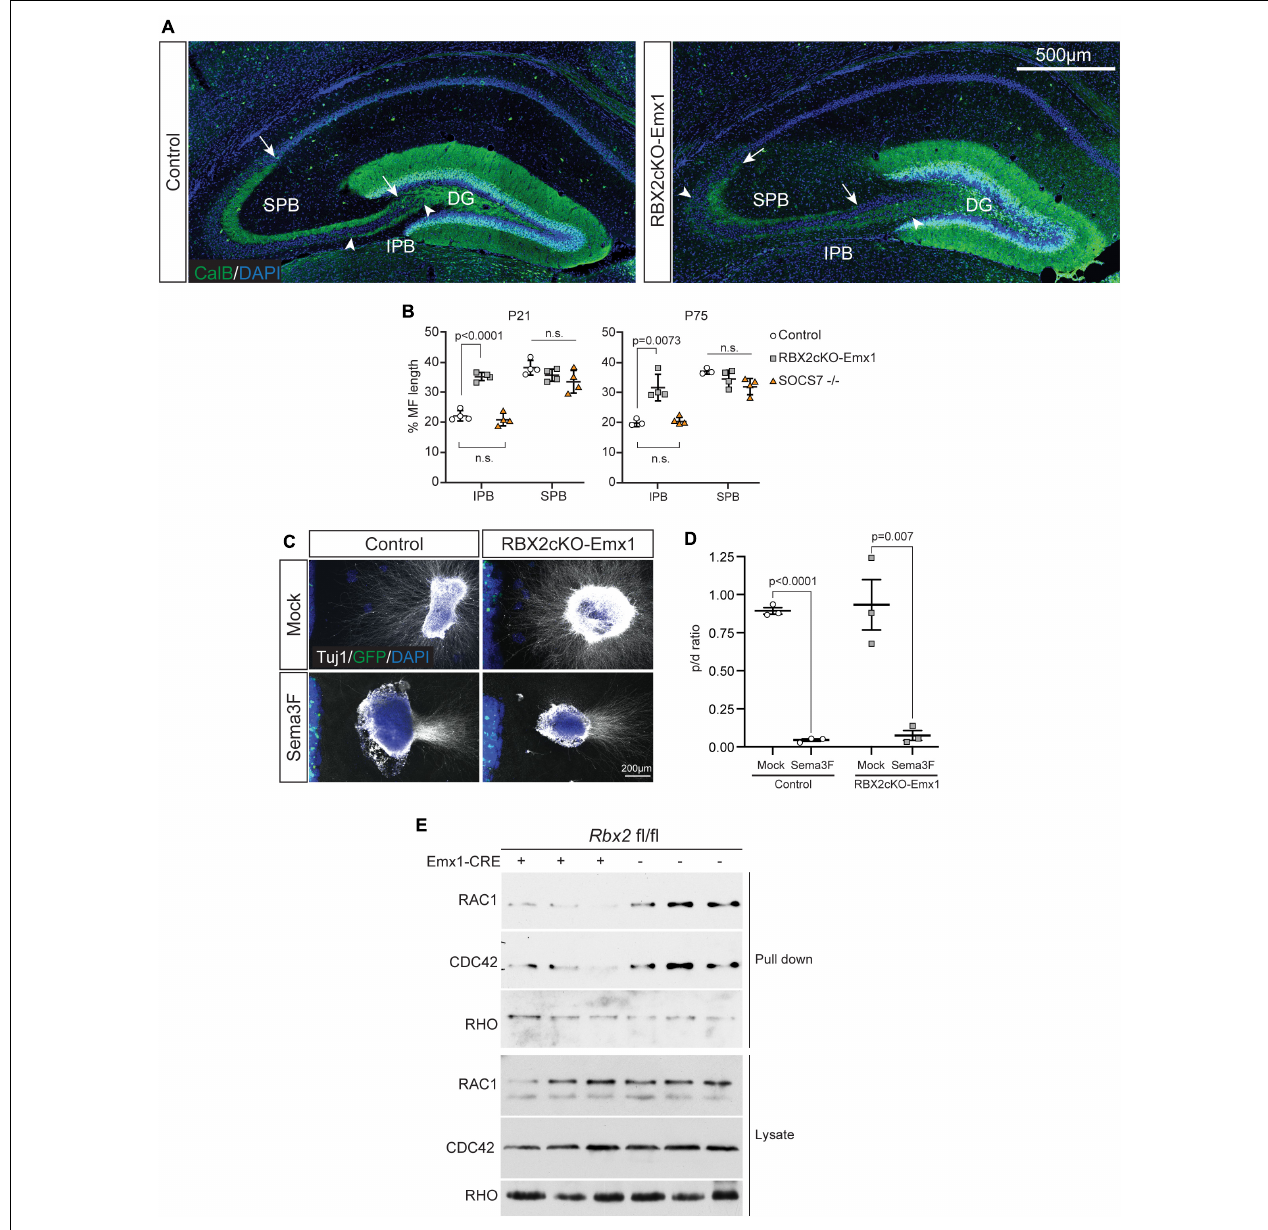
FIGURE 1 | RBX2 participates in mossy fiber IPB pruning. (A) IPB overextension in the RBX2cKO-Emx1 mice at P21. Stainings of control and RBX2cKO-Emx1 DG showed a similar extension of mossy fiber SPB (arrows demarcate SPB extension), whereas mossy fiber IPD was ectopically extended in the RBX2 mutant DG (arrowheads demarcate IPB extension). (B) Quantification of IPB extension in control, RBX2cKO-Emx1, and SOCS7 knock out (–/–) DG at P21 (left) and P75 (right). Mean ± SEM. Statistics, one-way ANOVA with Tukey’s method adjusted p -value. (C) Axons from E18.5 control and RBX2 mutant DG explant were repelled when confronted with a source of Semphorin-3F (Sema3F). Notice the HEK293T cell aggregate transfected with control plasmid or Sema3F-expressing plasmid on the left hand side of the image. For quantification, DG explants were divided in four quadrants and β -III-Tubulin fluorescent signal measured in proximal (in front of the cell aggregate) and distal (opposite) quadrants. (D) The ratio of proximal and distal (p/d) showed that both control and Rbx2 mutant DG axons were repelled by Sema3F. Mean ± SEM. Statistics, unpaired Student’s t -test. (E) Decreased RAC1-GTP and CDC42-GTP levels upon RBX2 depletion in comparison to control. RHO-GTP levels remained